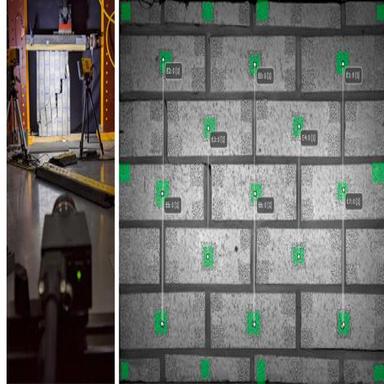
Storage of test specimen and transport setup.